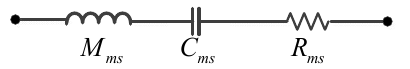
Figure 2. Equivalent circuit of electromagnetic domain.